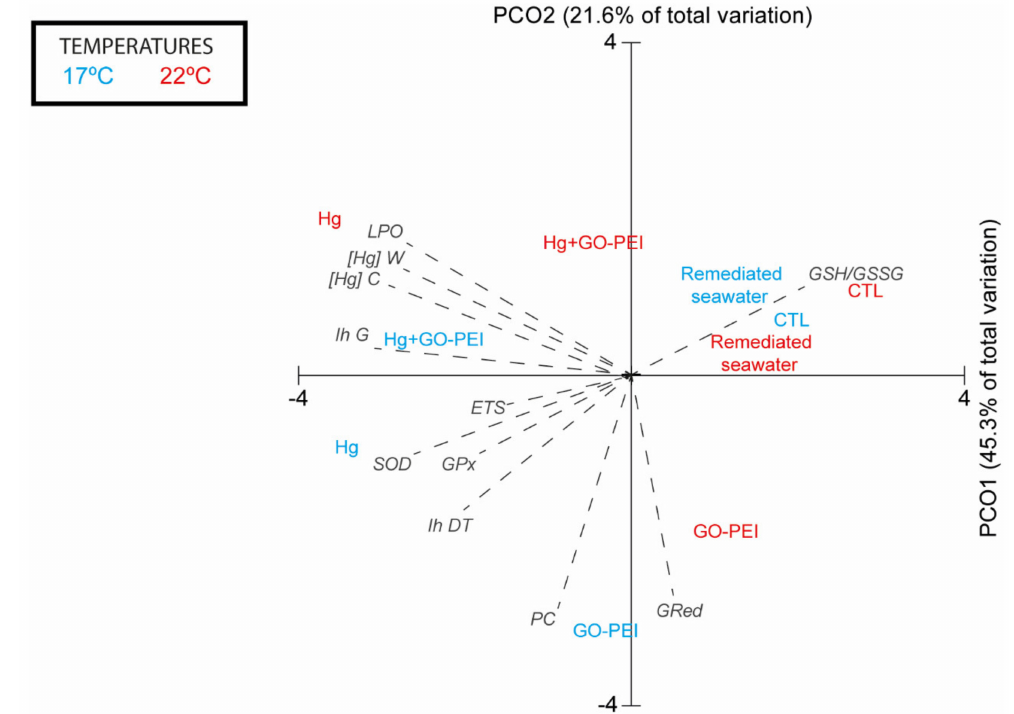
Figure 3. Principal coordinated ordination (PCO) analyses based on biochemical parameters, measured in Ruditapes philippinarum exposed to di ff erent conditions (CTL, GO-PEI, Hg + GO-PEI, Hg and Remediated seawater). Pearson correlation vectors are superimposed as supplementary